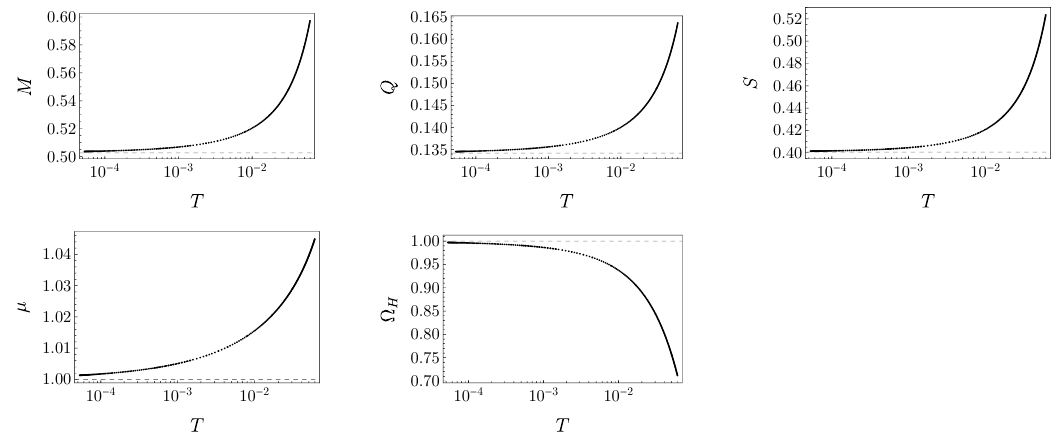
Figure 5 . Thermodynamic quantities against the temperature T , for black holes with (cid:12)xed angular momentum J = 0 : 05 and horizon scalar (cid:12)eld " H = 10 (cid:0) 4 (black data points). The dashed gridlines show the values for the supersymmetric black hole with the same J